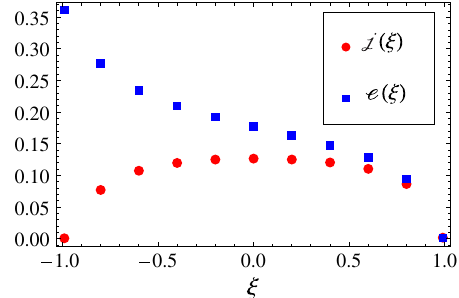
FIG. 2. The functions j ð ξ Þ (dots) and e ð ξ Þ (squares) for β 1 and β 30 in the sinh-Gordon model. L ¼ R ¼ Fig. 4, the relative deviation of the steady-state current from its bounds [Eq. (3)] is shown. The bounds are extremely tight, pointing to the strength of this constraint and confirming that the proposed solution is correct. The bounds are indeed so tight that it is difficult to distinguish some points in parts of Fig. 4. To better appreciate this, we present the numerical values of the points displayed in Fig. 4 (divided by β 2 ) in Table I. L